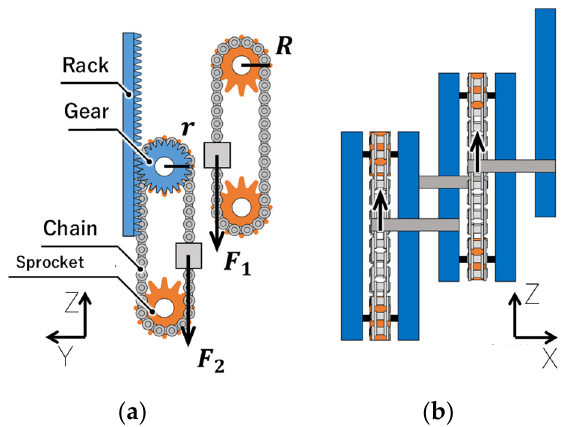
Figure 6. ( a ) Front view, ( b ) Side view. Interlocking unit.